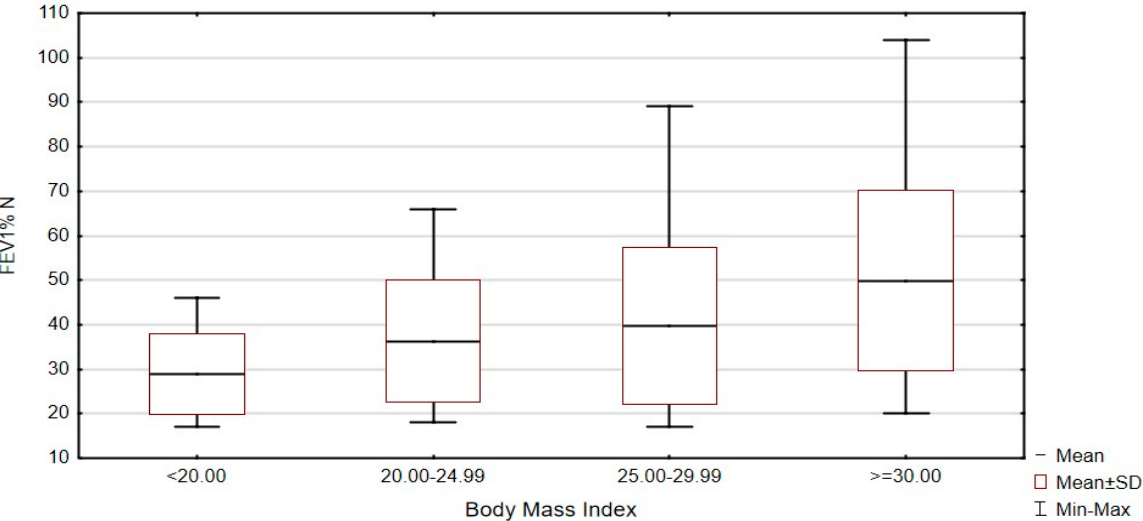
Figure 1. Assessment of the degree of airflow obstruction (FEV1% N) depending on the BMI (BMI < 20.00 BMI 20.00–24.99, BMI 25.00–29.99, BMI > 30.00) in patients treated with LTOT, Kruskal–Wallis test: H = 11.492; p = 0.0093, n = 110.